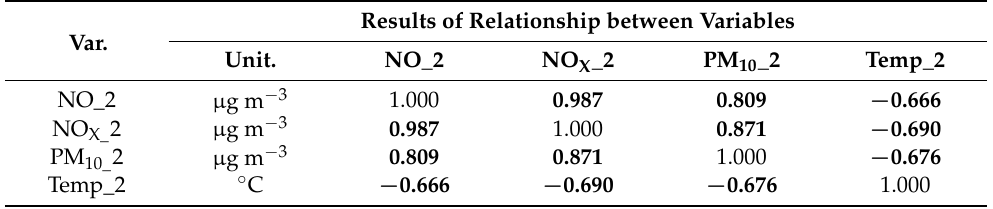
Table 4. Statistical values of selected indicators of air pollution and temperature in Krakow Agglomeration. Var.